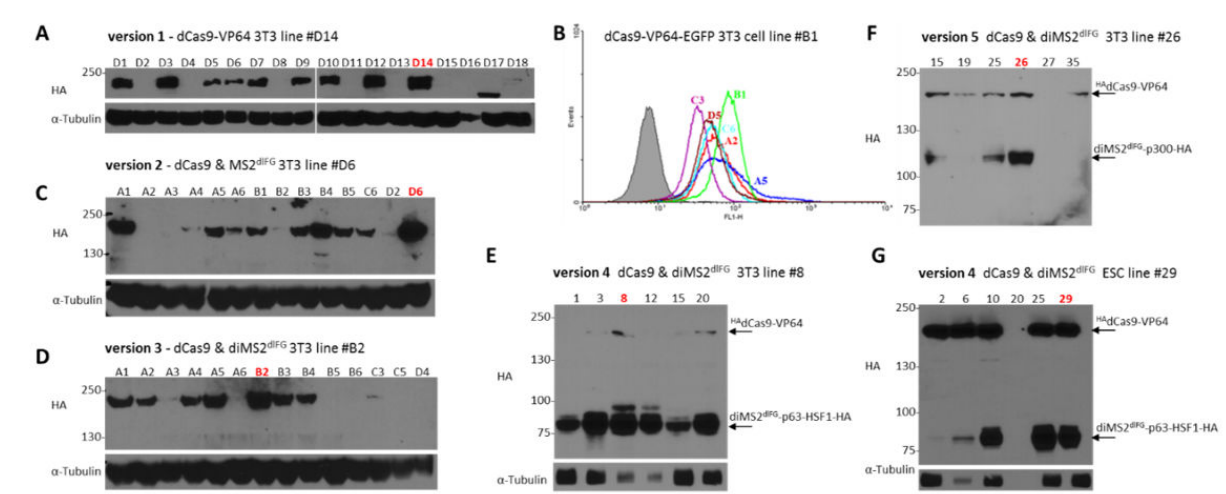
Figure A1. Overview of selected cell lines used in the work: ( A ) dCas9-VP64 3T3 line #D14 (version 1), used in Figure 2C,D, and Figure 3E, ( B ) dCas9-VP64-EGFP 3T3 cell line #B1 used in Figure 2C, ( C ) dCas9 and MS2 dlFG 3T3 line #D6 (version 2) used in Figure 3C, ( D ) dCas9 and diMS2 dlFG 3T3 line #B2 (version 3) used in Figure 3C,D, ( E ) dCas9 and diMS2 dlFG 3T3 line #8 (version 4) used in Figure 3C,E, and Figure 4D, ( F ) dCas9 and diMS2 dlFG 3T3 line #26 (version 5) used in Figure 3E, ( G ) dCas9 and diMS2 dlFG ESC line #29 (version 4) used in Figure 4C,E. Note that in single construct versions 2 and 3 (panels C , D ), the MS2-p65-HSF1 fusion protein construct is linked to HA-tagged dCas9-VP64 via a T2A self-cleavage peptide [23]. Thus, anti-HA antibody detects only dCas9. When dCa9 and MS2-p65-HSF1 are expressed separately, both proteins carry HA-tag and can be detected (panels E – G